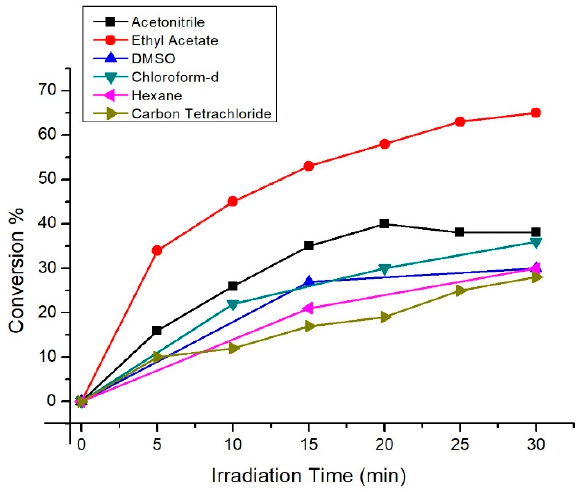
Figure 1. Conversion % vs irradiation time of CD-C 3 N 4 sensitized photooxidation of tetramethylethylene.